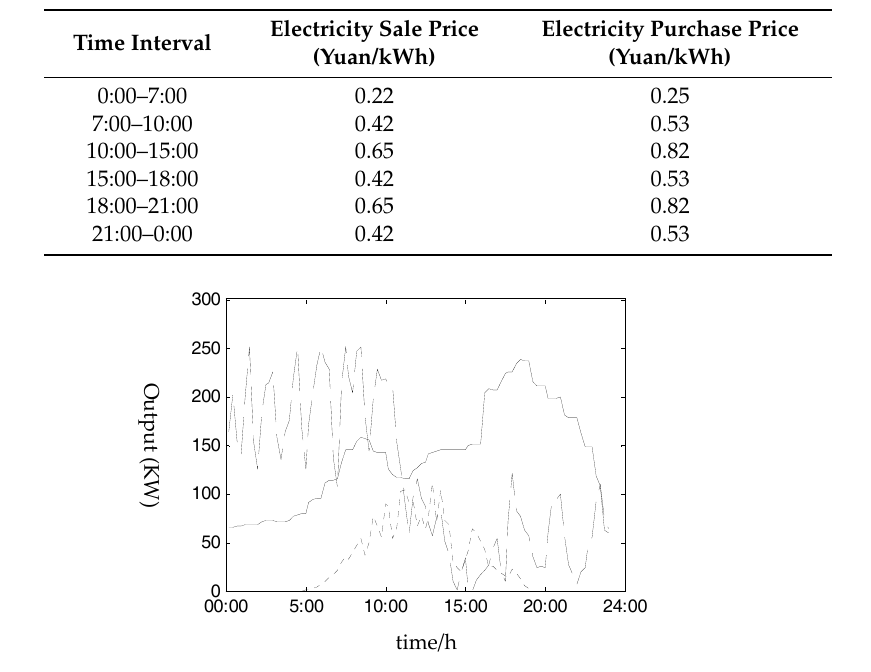
Table 2. The price of electricity sale and purchase.